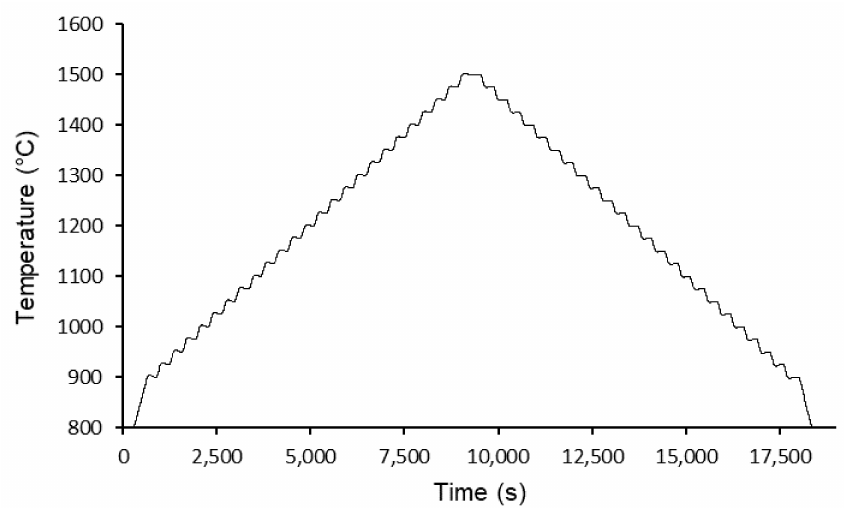
Figure 3. Temperature vs. time of the stacked CoCrCu system heating from 900 to 1500 ◦ C and back to 900 ◦ C in 25 ◦ C